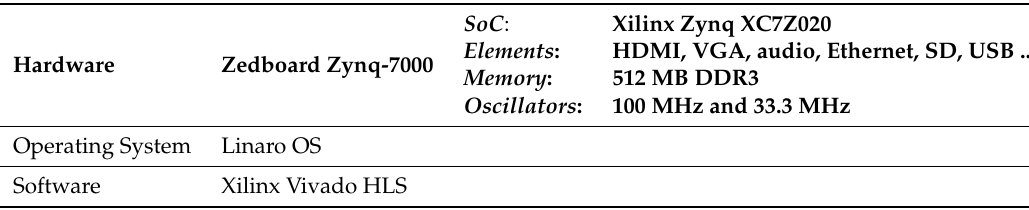
Table 1. Main tools for implementing BNMF in